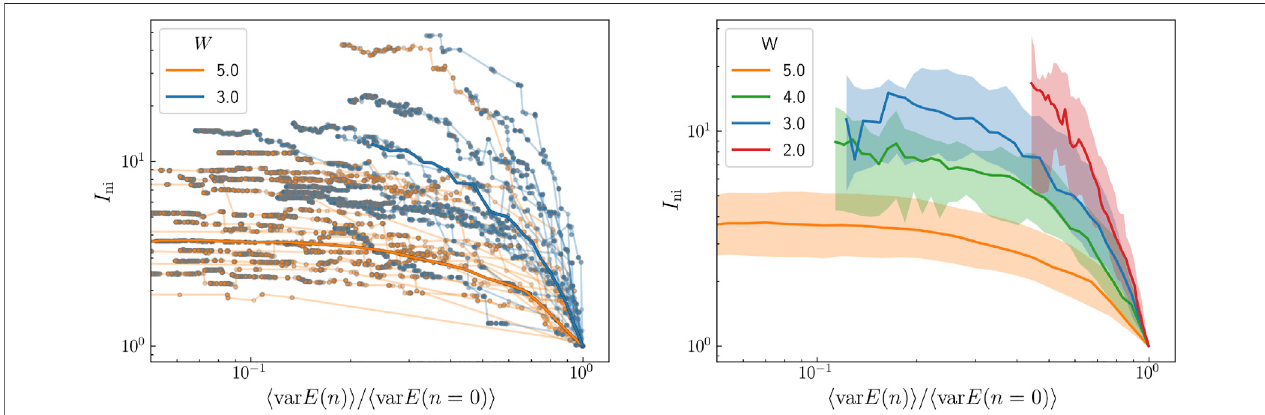
FIGURE3|(A) EvolutionoftheIPRversusthenormalizedenergyvarianceasdisplacementtransformationsareperformedforseveralstatesinadoublelogarithmic scale for L (cid:1) 20. Orange curves correspond to W (cid:1) 5 and blue curves to W (cid:1) 3. (B) Average IPR versus normalize energy variance for several values of the disorder. The width of the shaded region is equal to the IPR standard